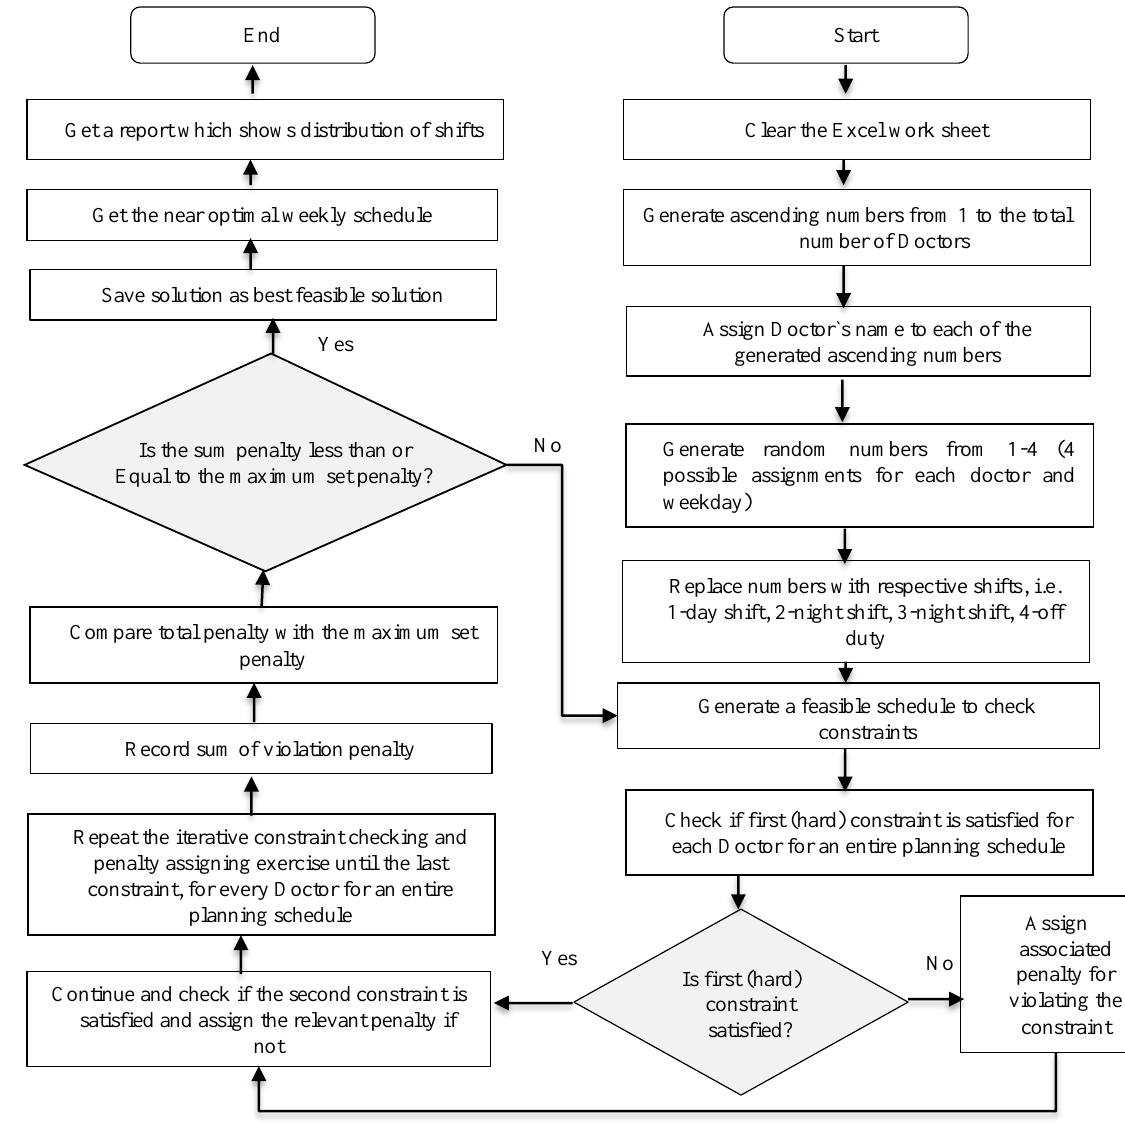
Figure 2. Methodological System